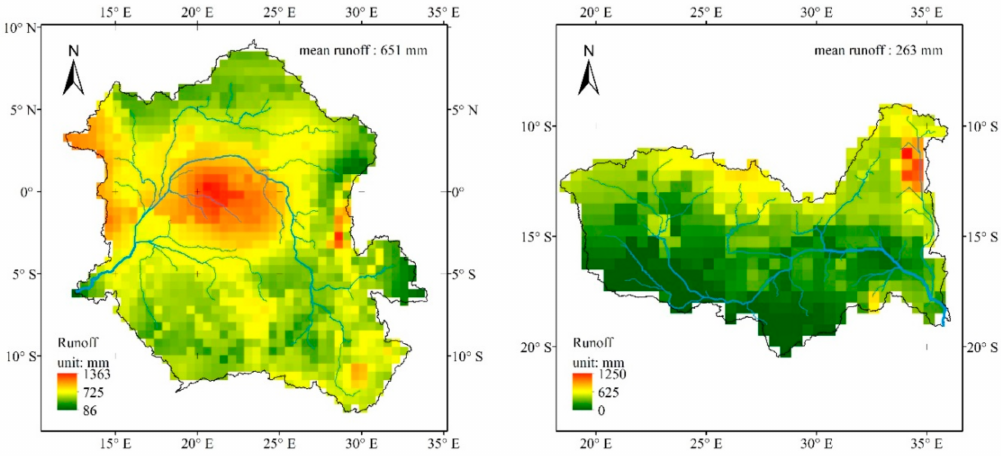
Figure 5. The original runoff maps of the Congo ( left ) and Zambezi ( right ) River basins.